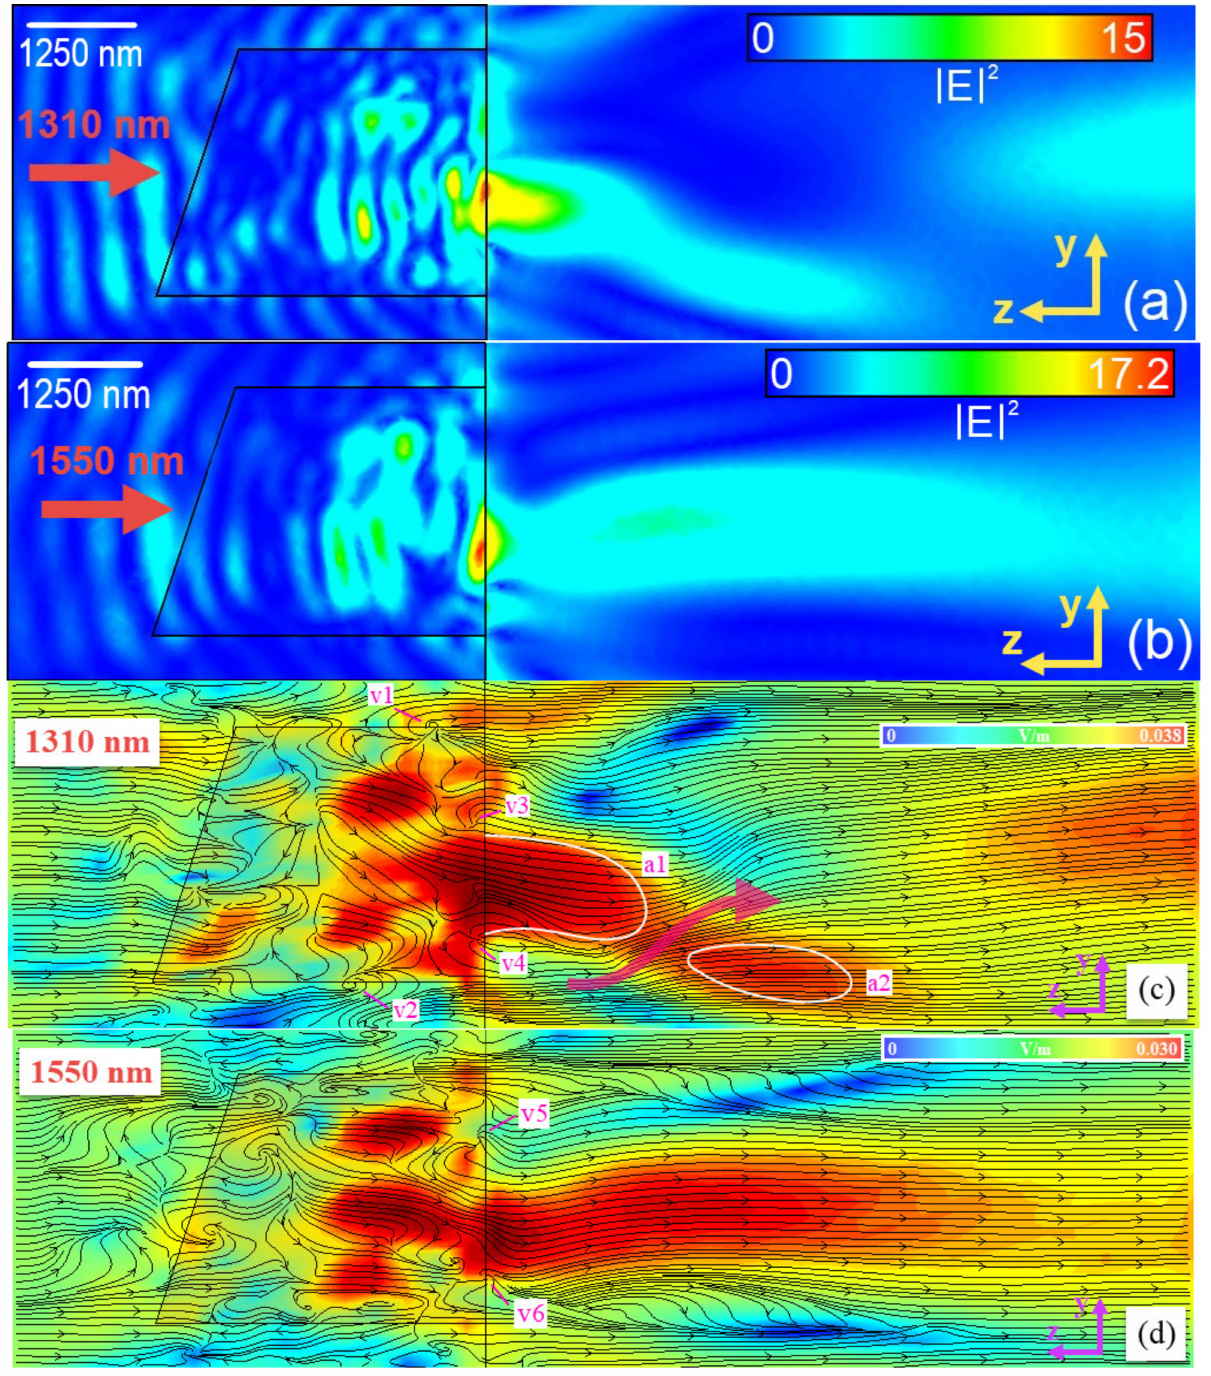
Figure 2. The distributions of the squared total magnitude of electric field ( | E | 2 ) for the irradiations with wavelengths of 1310 nm ( a ) and 1550 nm ( b ). Two-dimensional Poynting vector distributions for the irradiations with wavelengths of 1310 nm ( c ) and 1550 nm ( d ). The dimensions of the trapezoid particle are short base, 2.79 µ m; long base, 3.72 µ m; height, 2.79 µ m; thickness, 2.79 µ m; and prism angle, 71.57 ◦